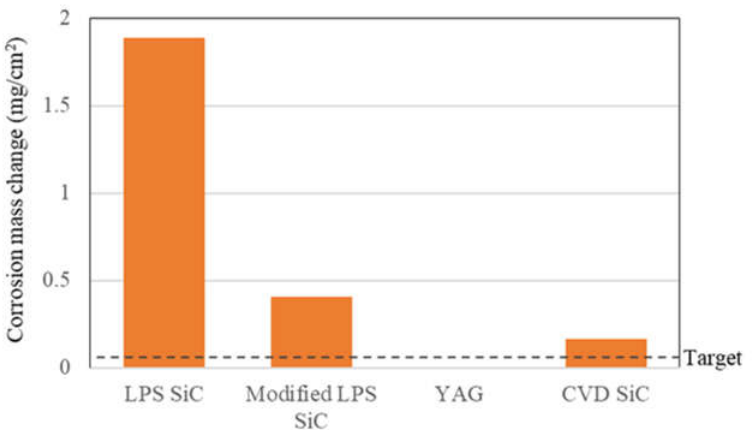
Figure 7. Corrosion mass changes of the LPS SiC, the modified LPS SiC, YAG, and CVD SiC following high-temperature water corrosion (2 ppm dissolved oxygen, 20 MPa, 320 °C, and 168 h).